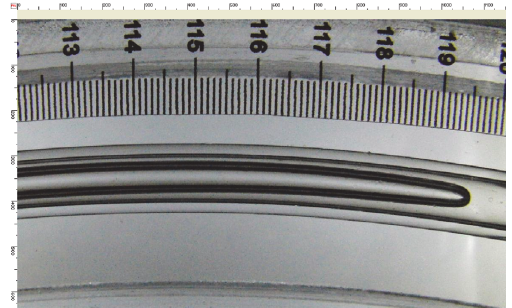
Figure 15: The original image loading software.